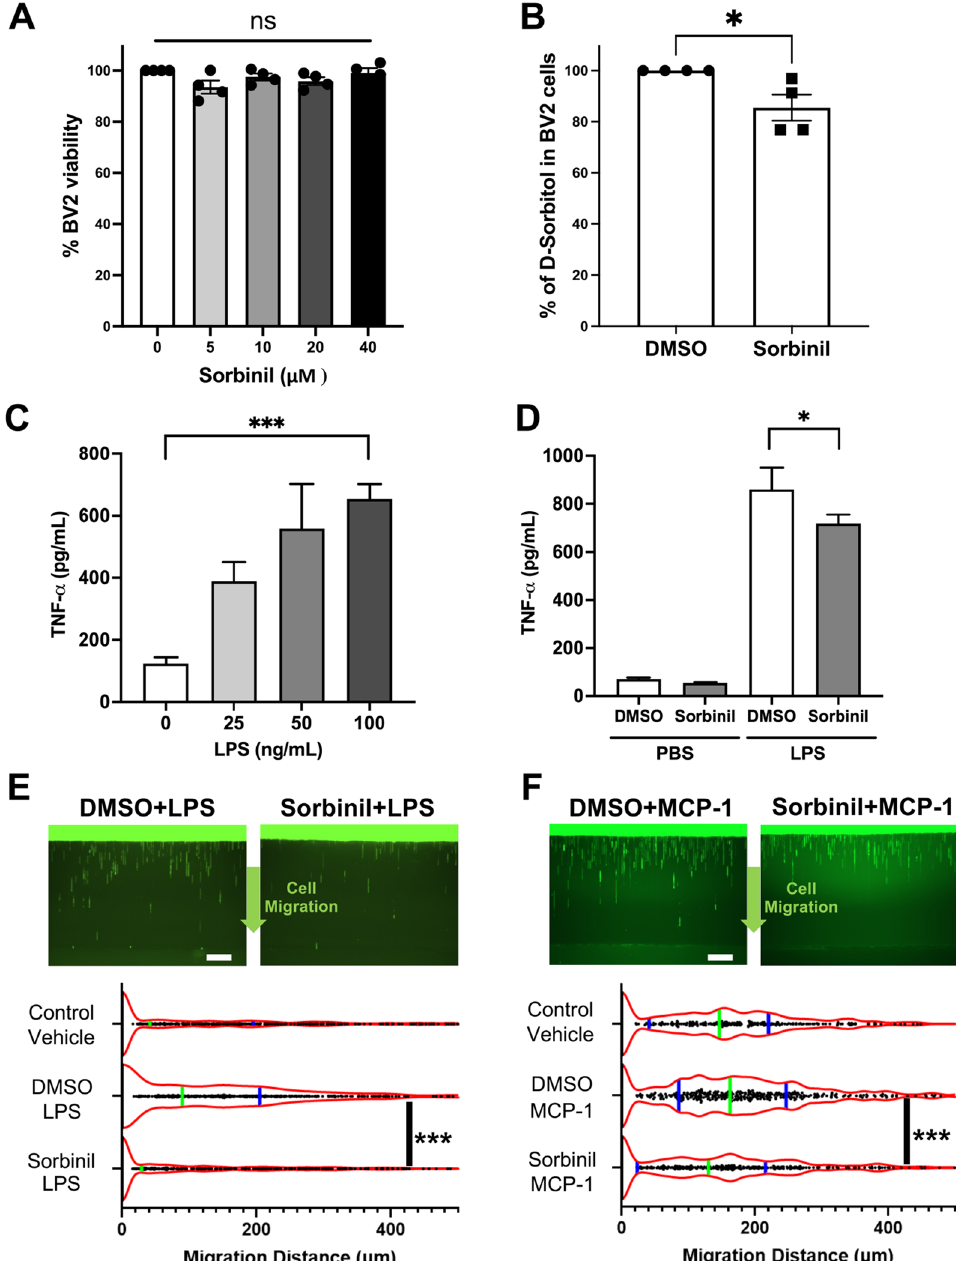
Figure 1. Sorbinil reduces LPS-induced cytokine expression and cell migration in BV2 microglia. (A) Sorbinil does not affect cell viability in BV2 microglia as measured by MTT assay. (B) Sorbinil treatment attenuates aldose reductase (AR) activity in BV2 microglia, as indicated by the decrease in D-sorbitol concentration. (C) LPS induces TNF-α secretion in a dose-dependent manner in BV2 microglia. (D) BV2 microglia treated with Sorbinil (20 μM) exhibit reduced TNF-α secretion in response to LPS (100 ng/mL) exposure, compared to vehicle-treated cells. BV2 microglia were pre-treated with Sorbinil (20 μM) for 1 h and then treated with LPS (100 ng/mL) or MCP-1 (30 ng/mL) N ≥ 3 per group. (E) Sorbinil treatment inhibits LPS-induced cell migration of microglia cells. Each dot represents the cell migration distance in a channel. The green bar represents the median, and the blue bars represent the quartiles. (n = 500–600 channels). (Scale bar = 200 µm) (F) Sorbinil treatment inhibits the chemoattraction of microglial cells induced by MCP-1. Each dot represents the cell migration distance in a channel. The green bar represents the median, and the blue bars represent the quartiles. (n = 300–400 channels). (Scale bar = 200 µm). Statistical significance was determined using Student’s t-test ( ***P <